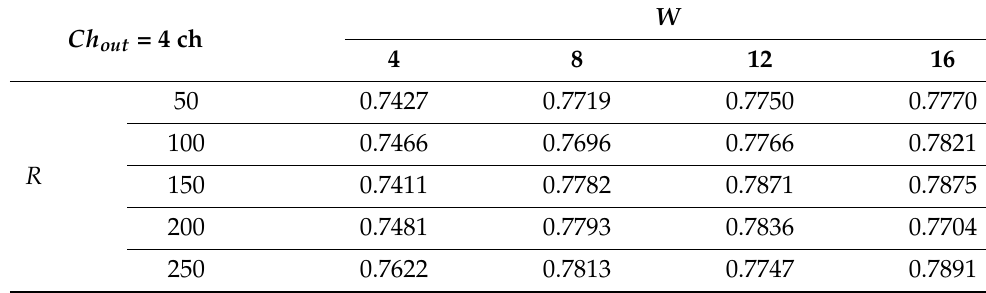
Table 9. Accuracy of parameter search at Ch out = 4